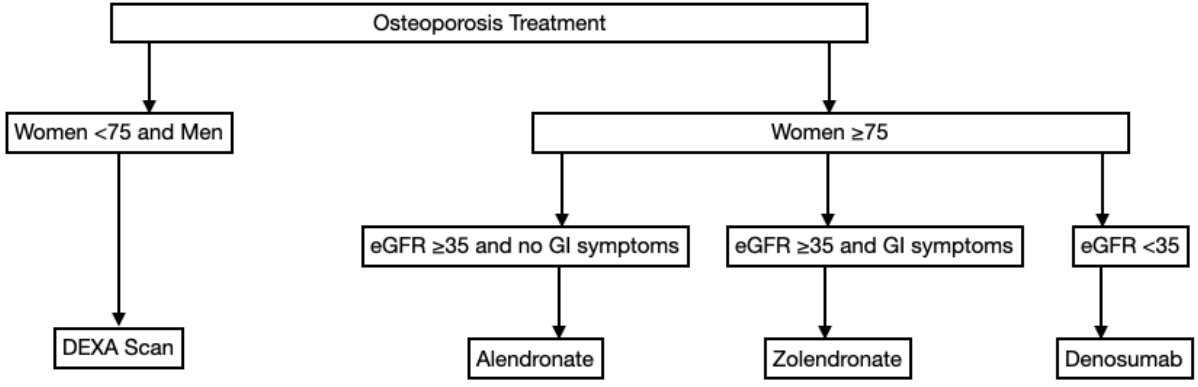
Figure 2. Osteoporosis assessment and treatment for patients with femoral neck fractures as per the University Hospital of Coventry and Warwickshire guidelines. eGFR: estimated glomerular filtration rate; DEXA: dual energy X-ray absorptiometry; GI: